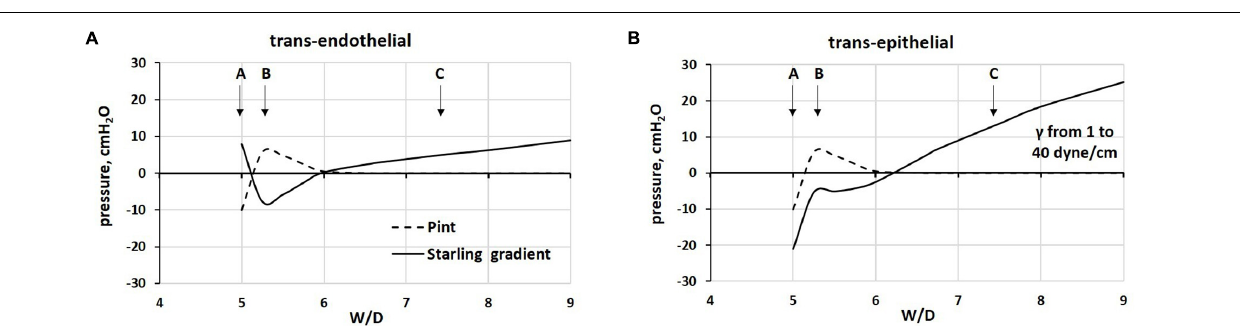
with both flows. For W/D > 6.5, both trans-endothelial